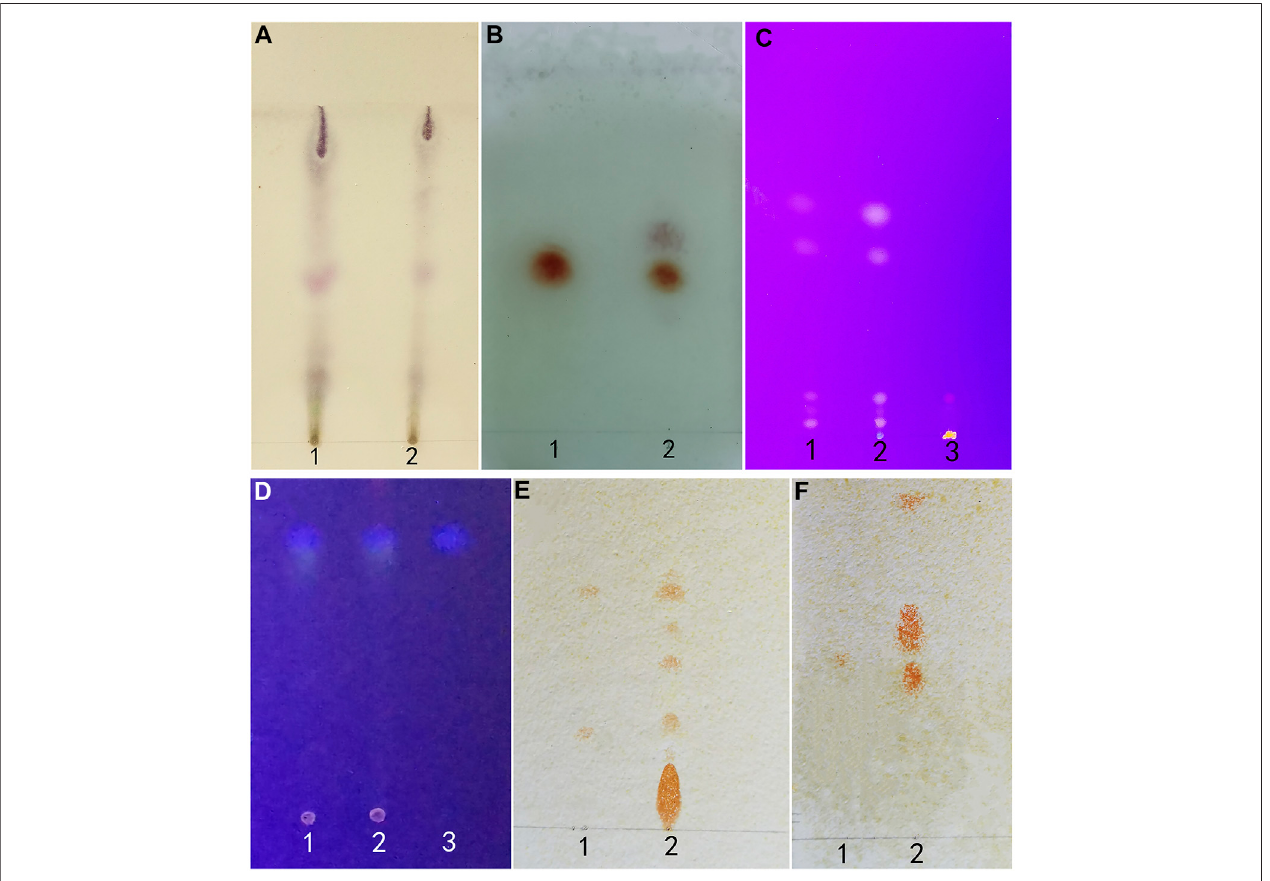
FIGURE 7 | (A) ( Artemisia Argyi Folium ): 1 test herb 2 control herb. (B) ( Borneolum ): standard herb 2 test herb. (C) ( Rhei Radix et Rhizoma ): 1 control herb 2 test herb 3 standard herb. (D) ( Fructus Cnidii ): 1 standard herb 2 test herb 3 control herb. (E) ( Sophorae Flavescentis Radix ): 1 matrine and sophoridine 2 test herb. (F) ( Sophorae Flavescentis Radix ): 1 oxymatrine 2 test